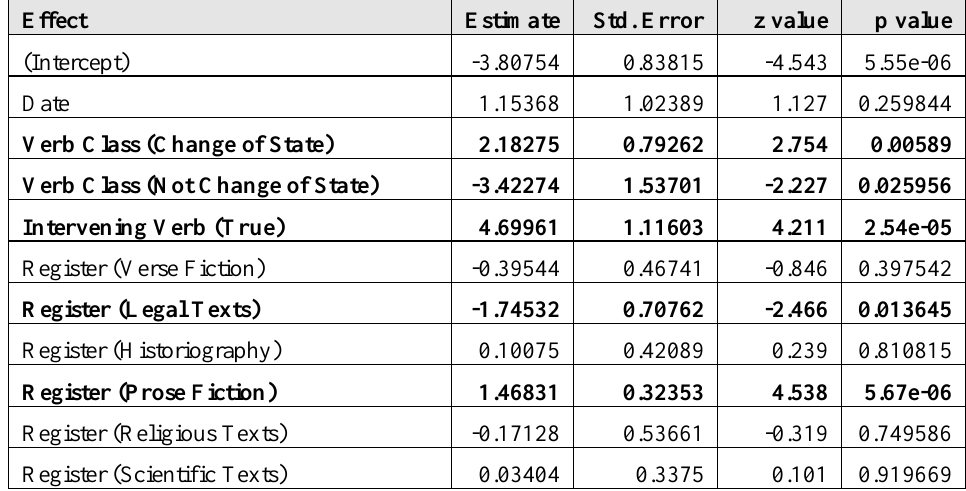
Table 7. Results of Mixed-Effects Logistic Regression Analysis